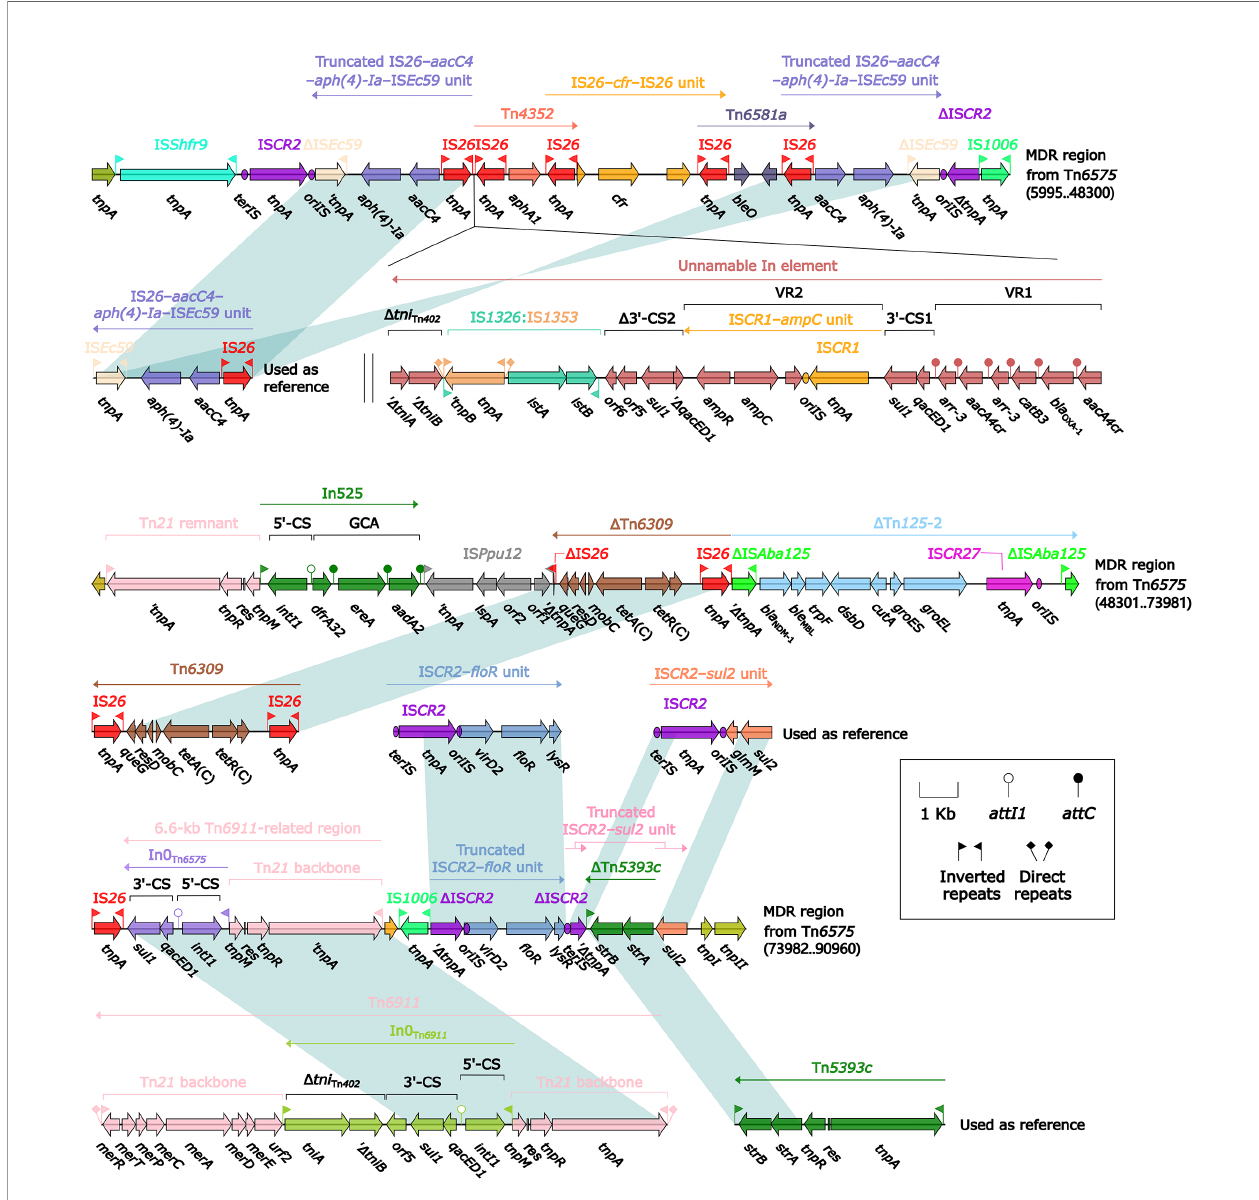
FIGURE 4 | Organization of MDR region from Tn 6575 , and comparison to related regions. Genes are denoted by arrows. Genes, mobile elements, and other features are colored based on their functional classi fi cation. Shading denotes regions of homology (nucleotide identity ≥ 95%). Numbers in brackets indicate nucleotide positions within Tn 6575 . The accession numbers of IS 26 – aacC4 – aph(4)-Ia – IS Ec59 unit, Tn 6309 (Sun et al., 2016), Tn 6911 , Tn 5393c (L ’ Abe ́ e-Lund and Sørum, 2000), IS CR2 – fl oR unit, IS CR2 – sul2 unit used as reference are CP042857, KX710094, KT033469, AF262622, CP042857, and AE014073,